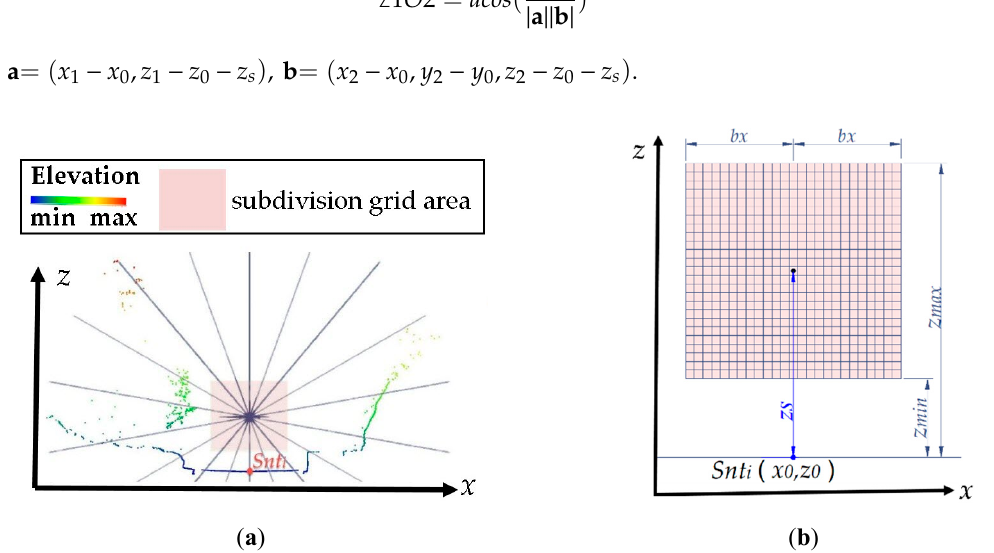
Figure 7. A scanning plane reconstructed by a single scan line. ( a ) A scanning plane divided by many directions. ( b ) The size and position of the subdivision grid area. directions. ( b ) The size and position of the subdivision grid